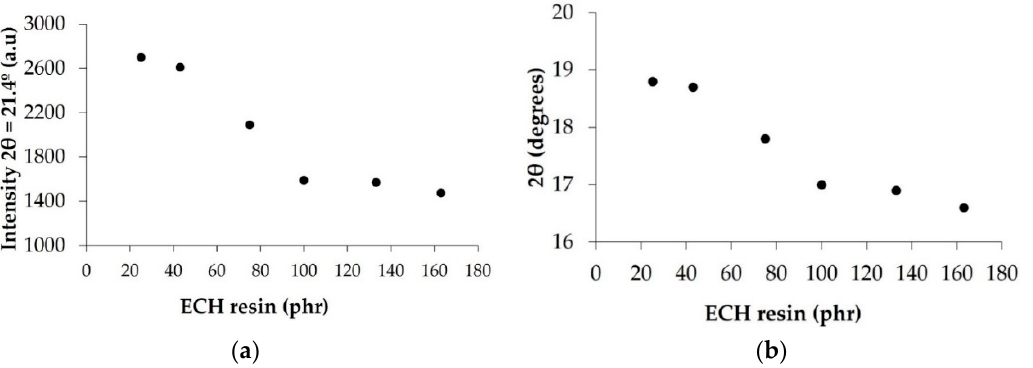
Figure 6. ( a ) Variation of the intensity of the diffraction peak at 2 θ = 21.4 degrees of the EBA copolymer + ECH resin blends as a function of their ECH resin content. X-ray diffraction experiments. ( b ) Variation of the 2 θ value of the amorphous part of the EBA copolymer + ECH resin blends as a function of their ECH resin content. X-ray diffraction experiments.